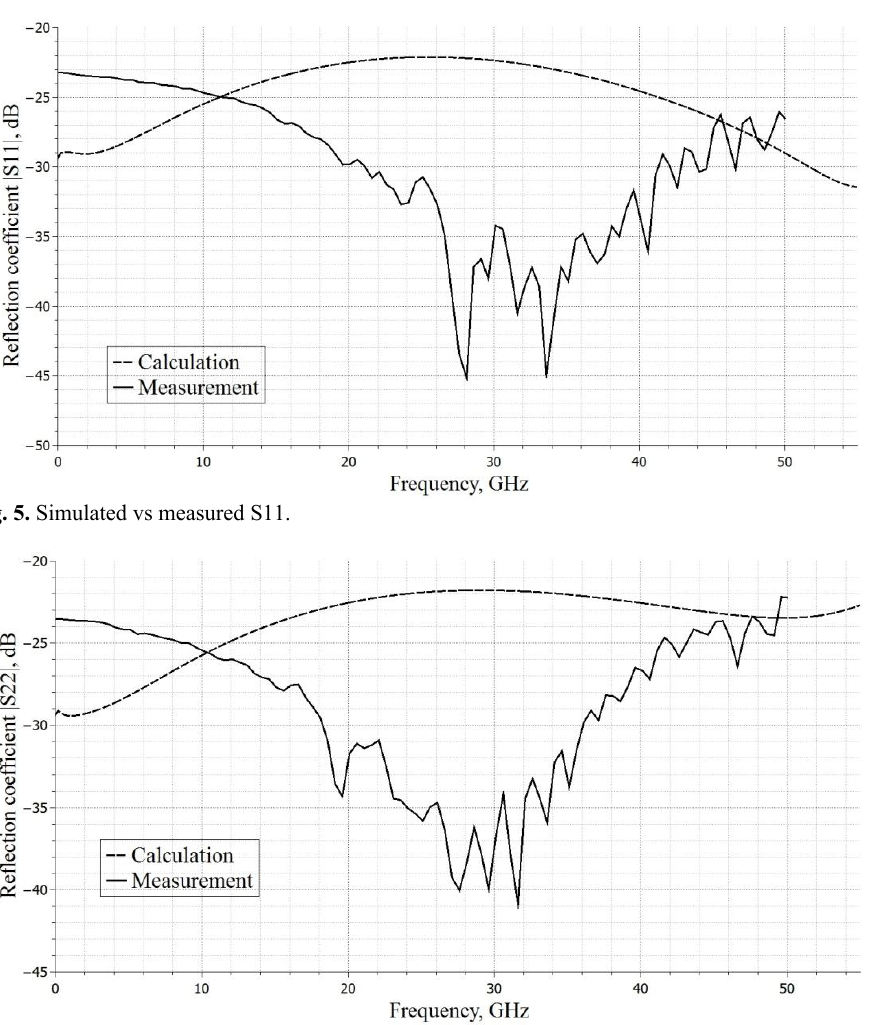
Fig. 6. Simulated vs measured